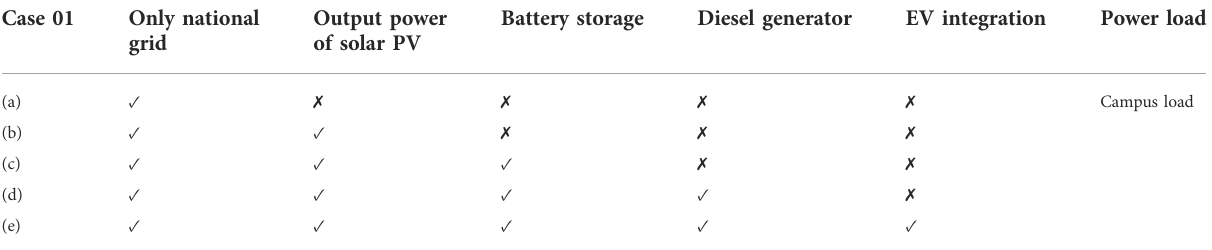
TABLE 4 Pro fi le of case studies.